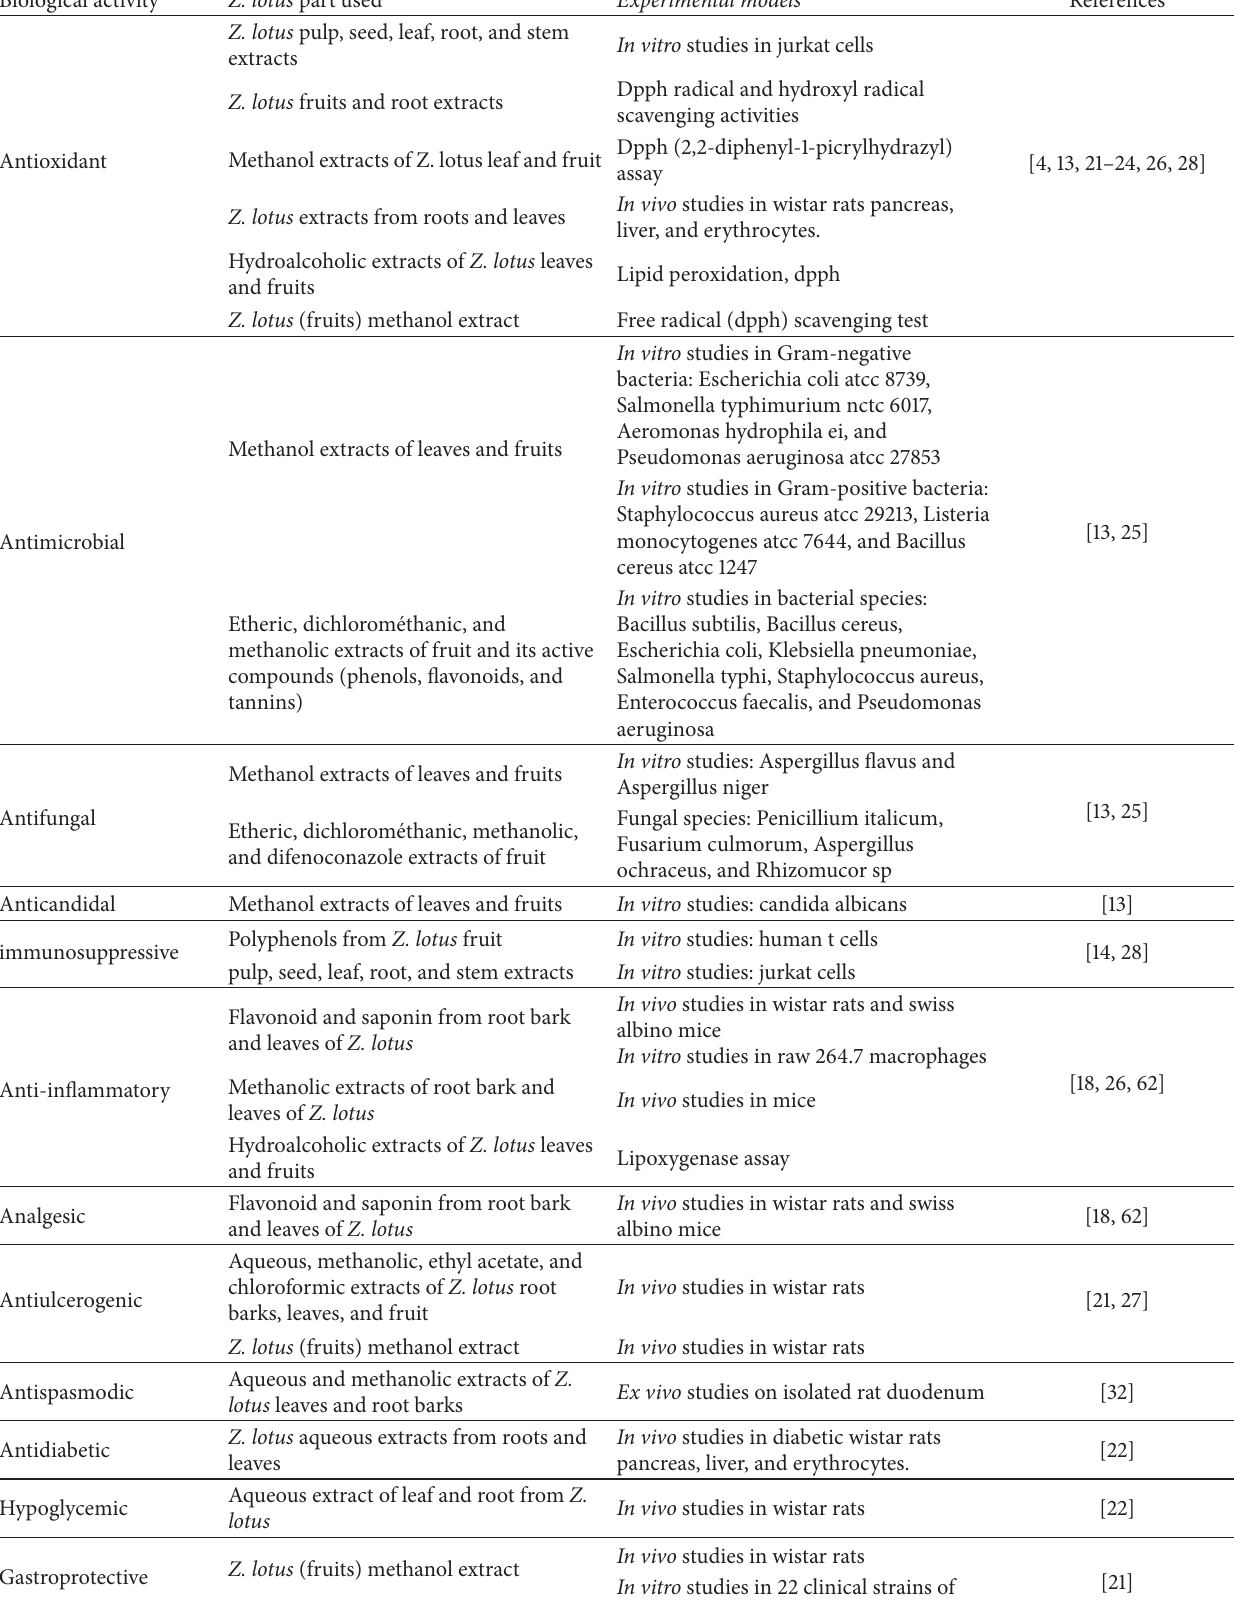
Table 8: Overview of major bioactive effects of Z. lotus preparations in different experimental models. Biological